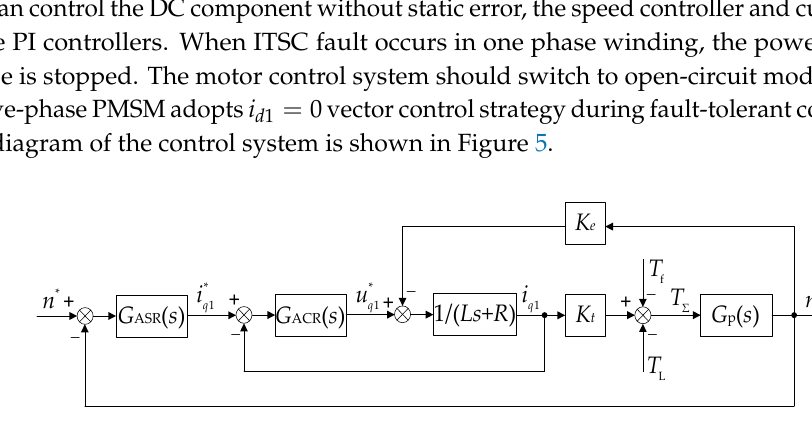
Figure 5. Speed–current dual-closed loop block diagram considering torque ripple.